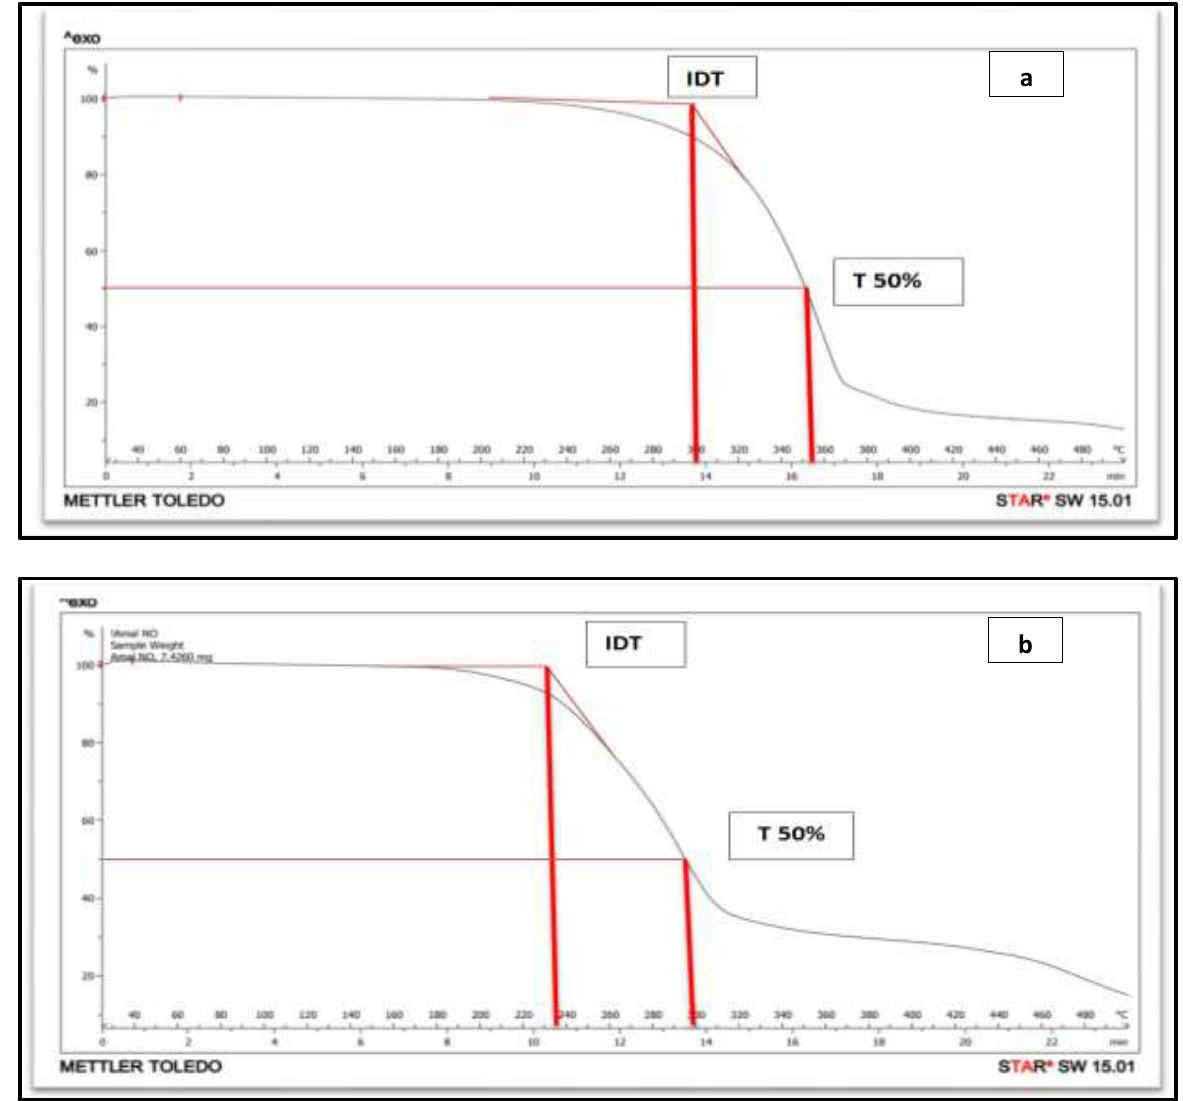
Figure 7. TGA of pure paracetamol (a) and TGA of pure naproxen